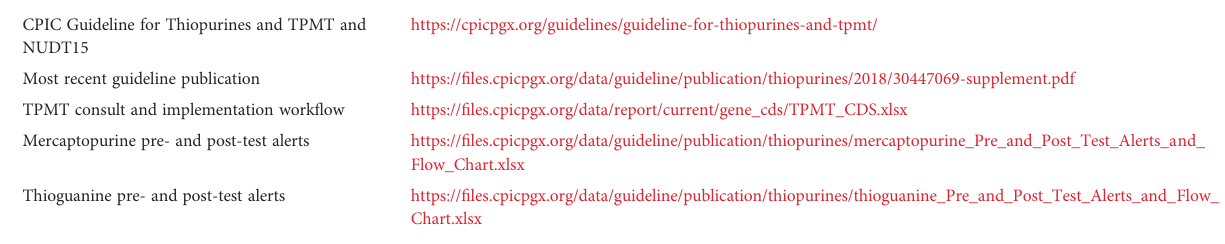
TABLE 1 Web locations of CPIC